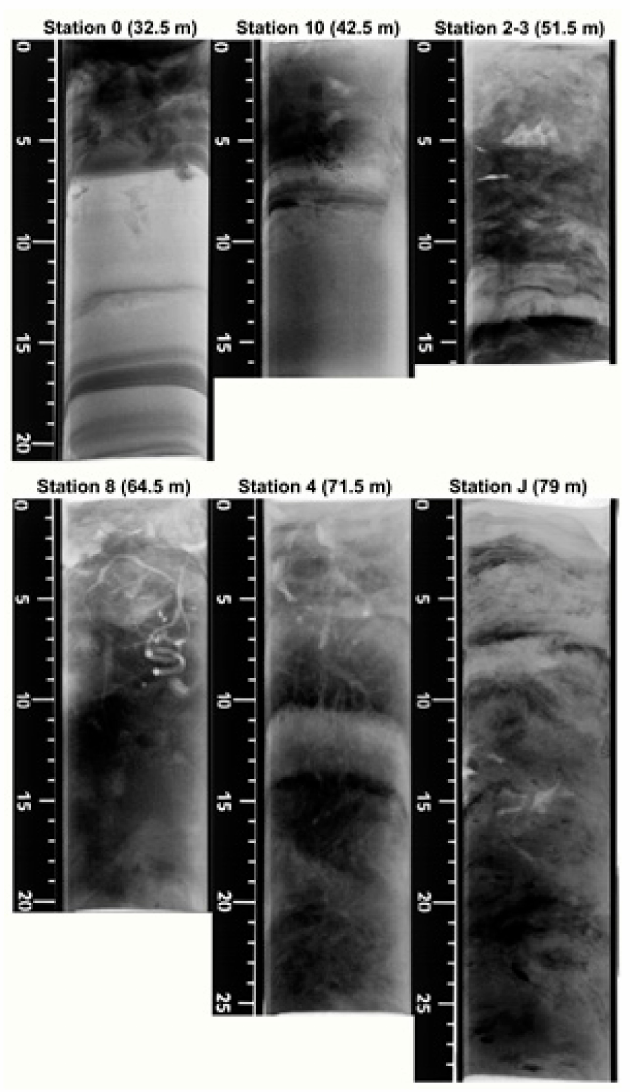
Figure 5. Examples of X-rays radiographies (positives; scale in cm) collected at six stations located along the sampled depth gradient (see Figure 1). Station codes are the same as in Figure 1 and Table